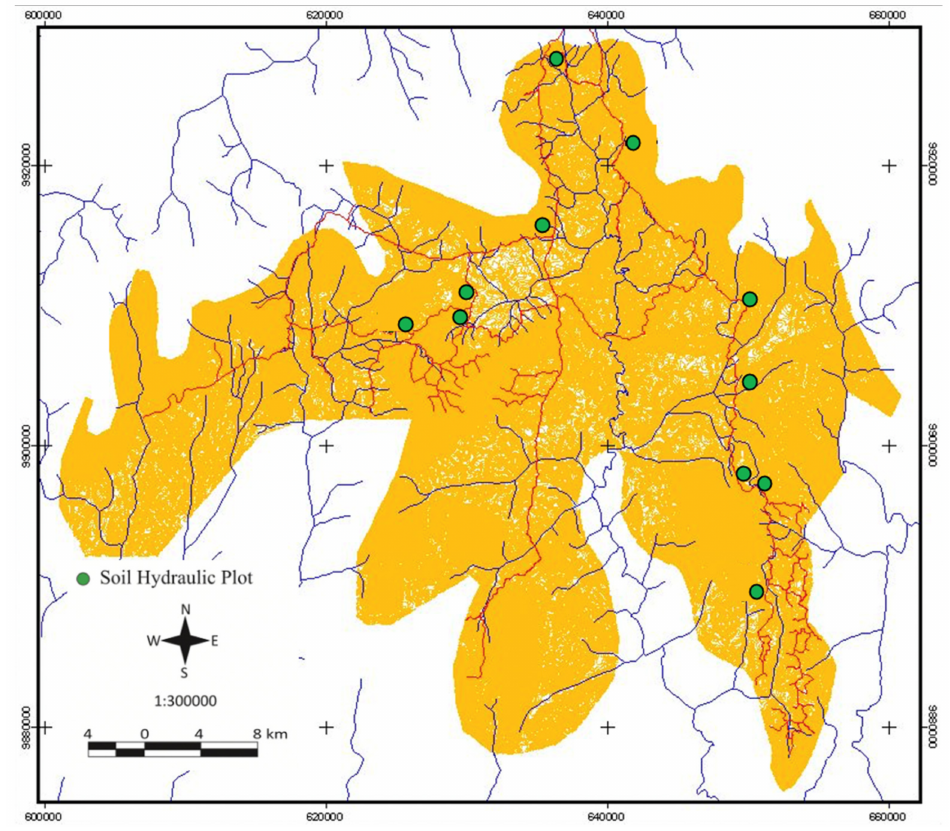
Figure 1. Location of the experimental plots for soil hydraulic